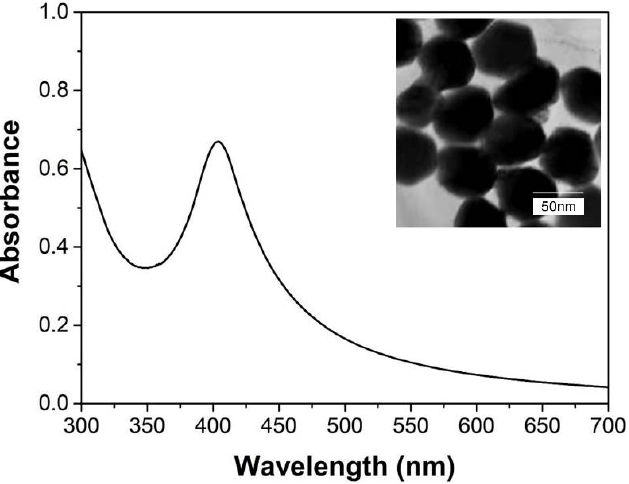
Figure 1. Spectrum of absorption spectrum and image of TEM of Ag nanoparticles.